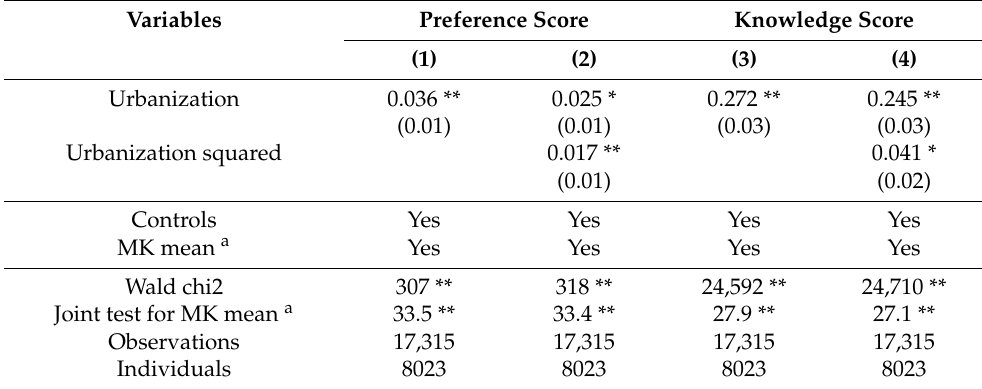
Table 7. The effect of urbanization on food preference and dietary knowledge.